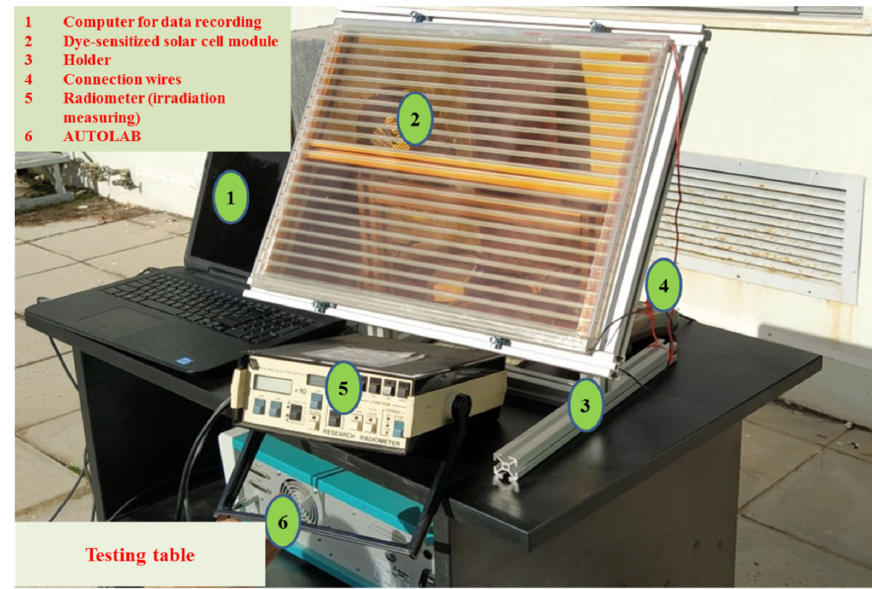
Figure 4. Experimental setup of the dye-sensitized panel characteristics determination.